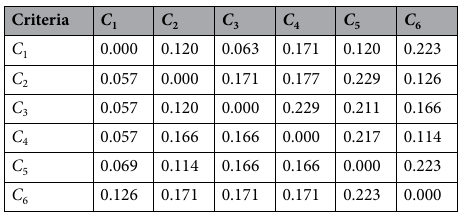
Table 2. The normalized direct-influence matrix H .